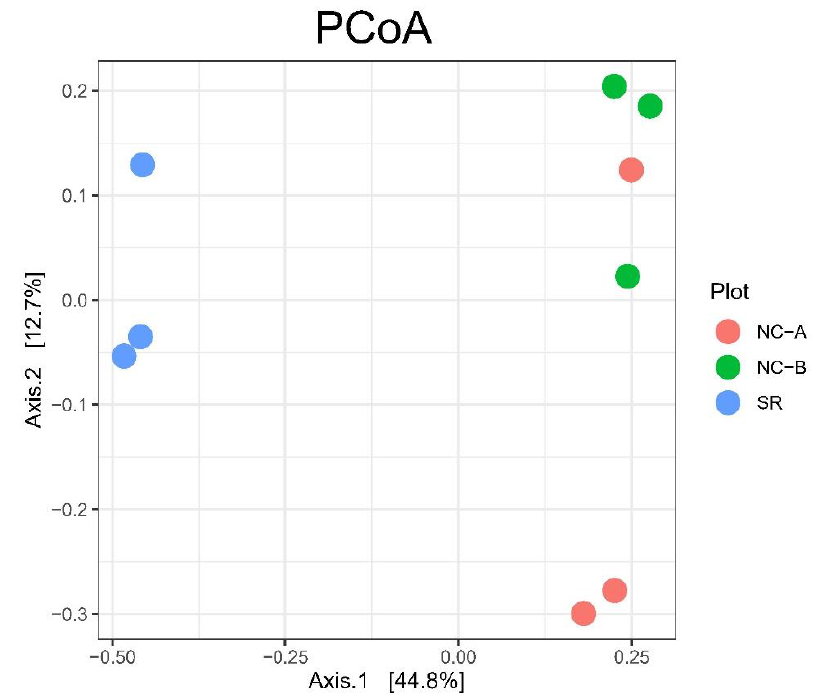
Figure 5. Principal coordinate analysis (PCoA) based on Bray–Curtis distances matrix of Illumina MiSeq sequencing fungal data of soil samples taken from pear orchards in Soracá (SR) and Nuevo Colón (steep slope plot at higher altitude: NC-A; flat plot at lower altitude: NC-B).